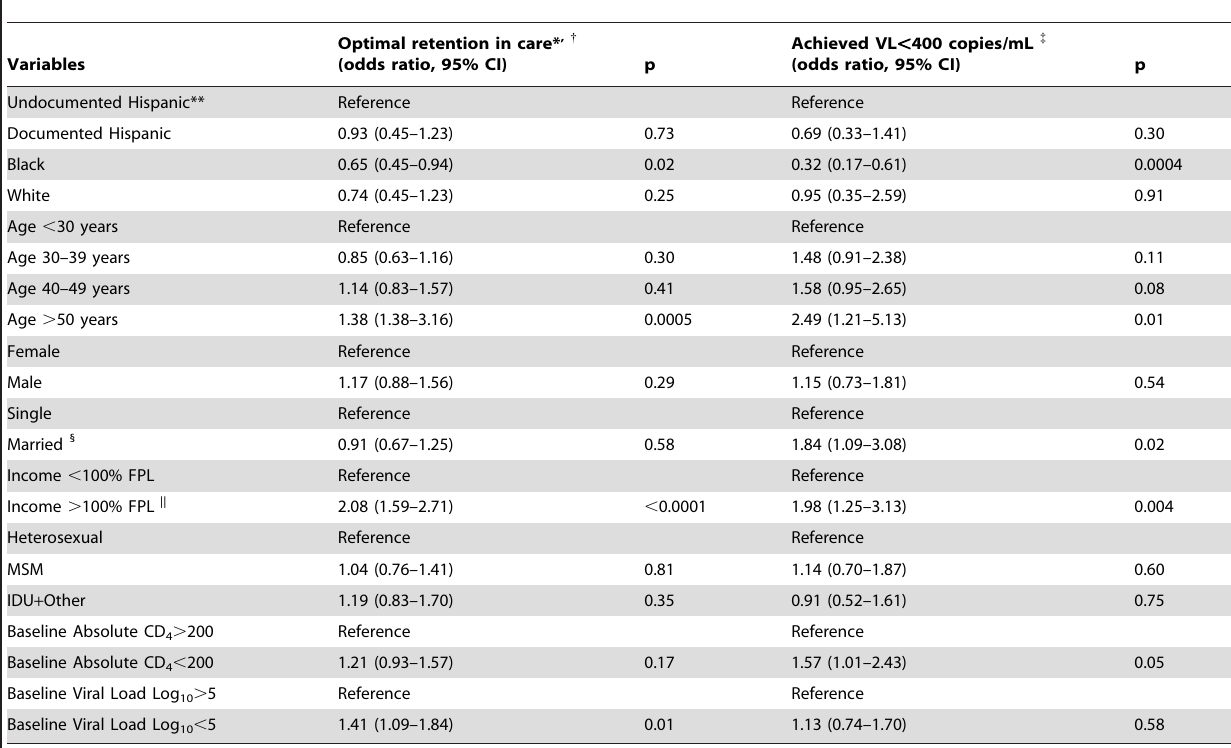
Table 3. Multivariable analysis of retention in care and HIV suppression one year after initiating care at Thomas Street Health Center in Houston,